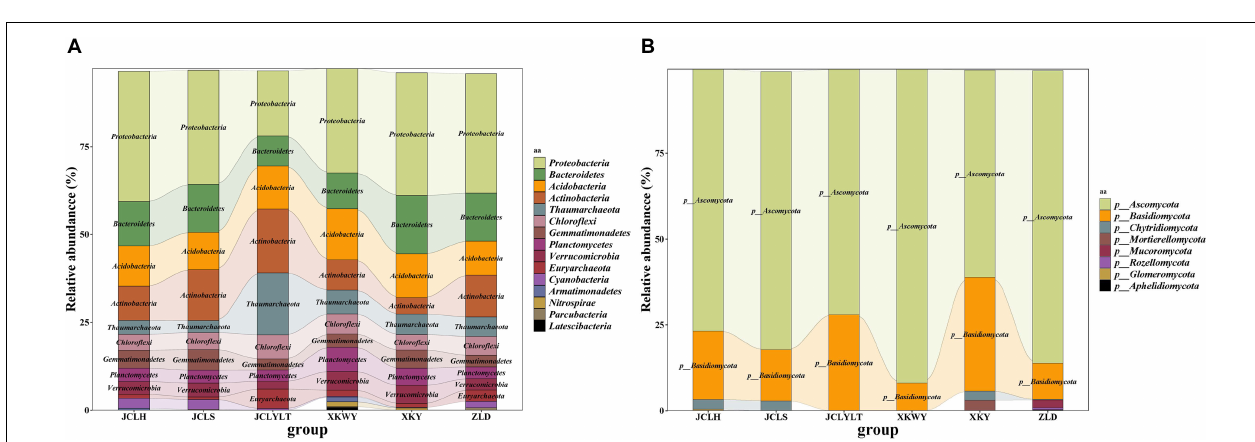
FIGURE 3 | The relative abundance of (A) bacterial community and (B) fungal